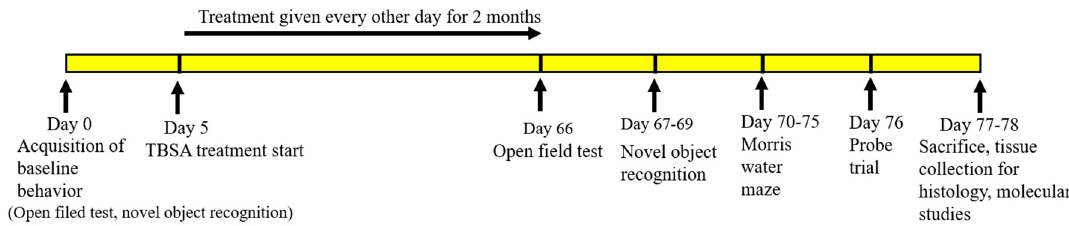
Figure 12. Schematic diagram showing experimental design and treatment paradigm.